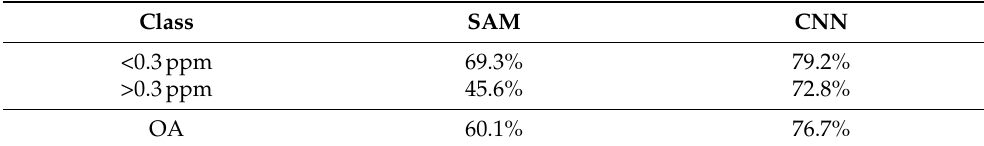
Table 1. Per-class accuracy and overall accuracy (OA) of classification relative to reference data for the binary classification problem.